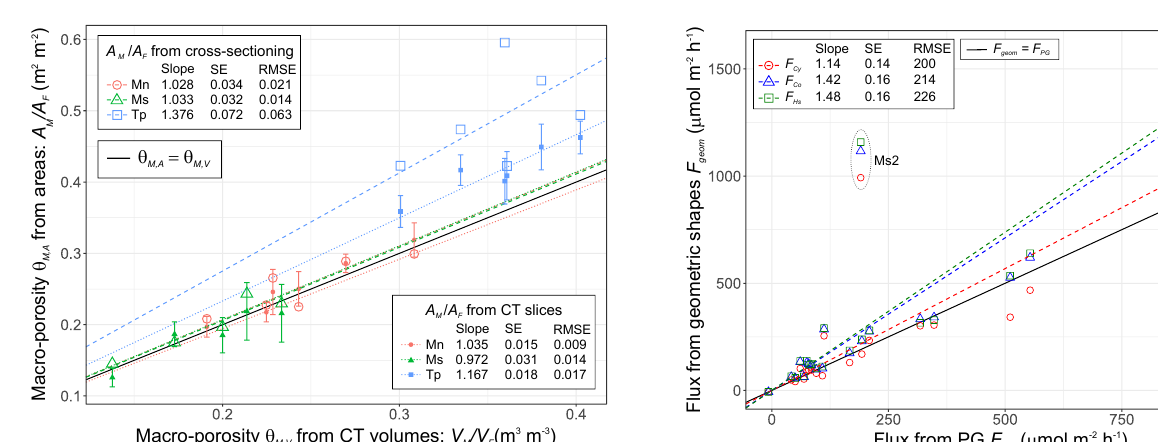
Figure 6. Comparison of CH 4 flux calculated according to Eq. (1) with TM epigeal volumes V TM and basal areas A B from pho- togrammetry ( F PG ), and with TM volumes approximated by three geometric shapes: a cylinder ( F Cy ), a cone ( F Co ) and a hemi- spheroid ( F Hs ). Considering PG as the reference method, fluxes were overestimated by 14 ± 14% for the cylinder, 42 ± 16% for the cone and 48 ± 16% for the